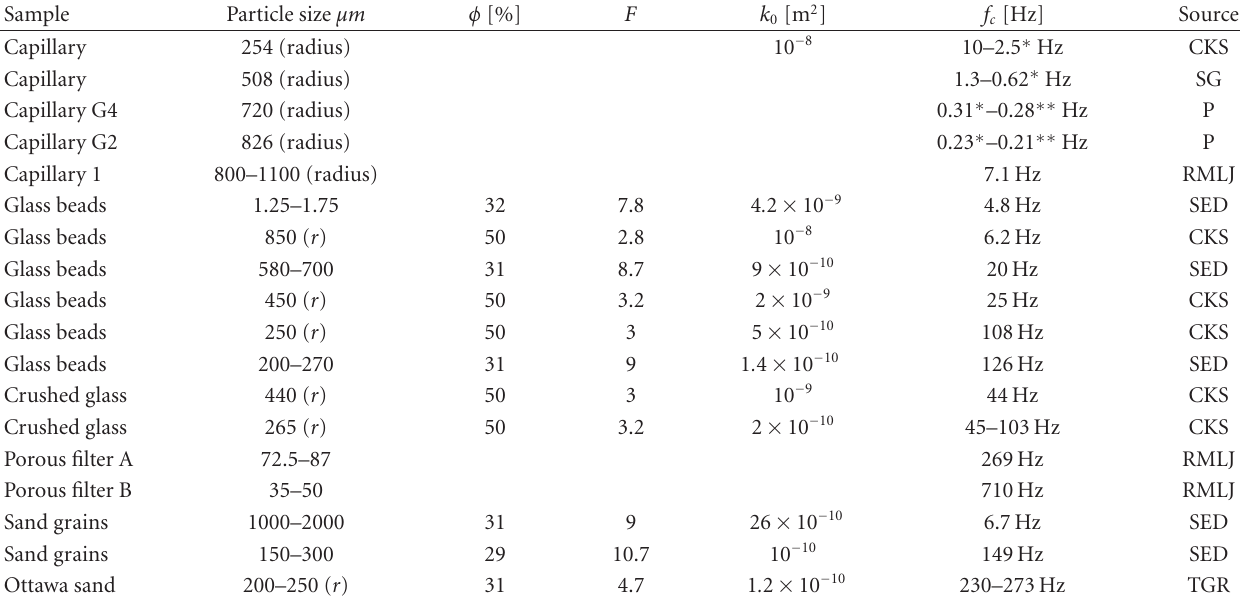
Table 1: Measured or predicted transition frequency for dynamic streaming potential and permeability, for samples of porosity φ , formation factor F , permeability k 0 , and half of the mean particle size r , from (SED) Smeulders et al. [61], (CKS) Charlaix et al. [62], (SG) Sears and Groves [63], (P) Packard [59], (TGR) Tardif et al. [64], and (RMLJ) Reppert et al. [60]. ∗ Indicates predicted transition frequency from (3) and ∗∗ indicates the transition frequency computed by the